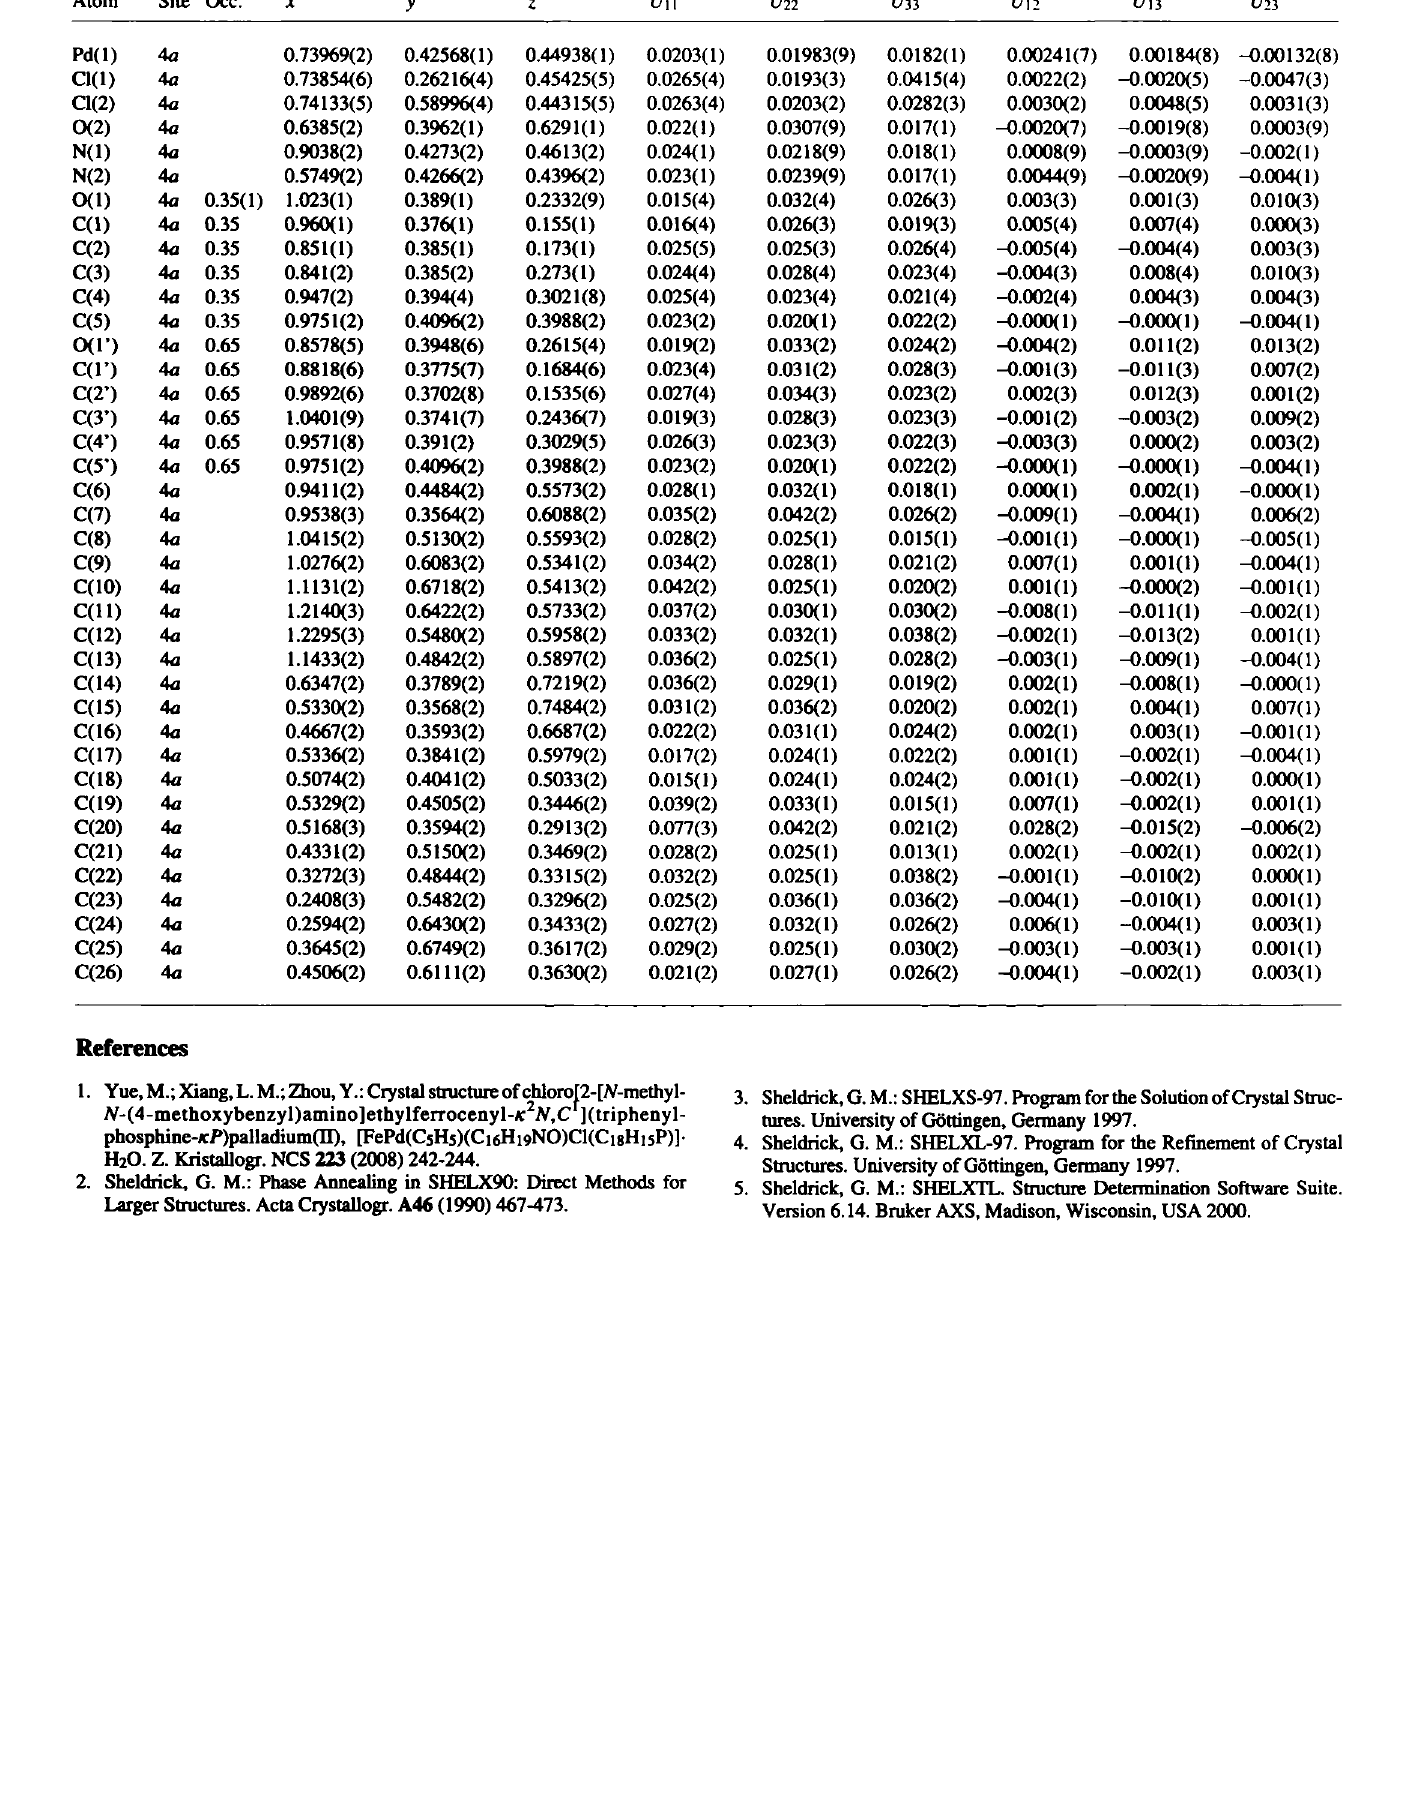
Table 3. Atomic coordinates and displacement parameters (in À 2